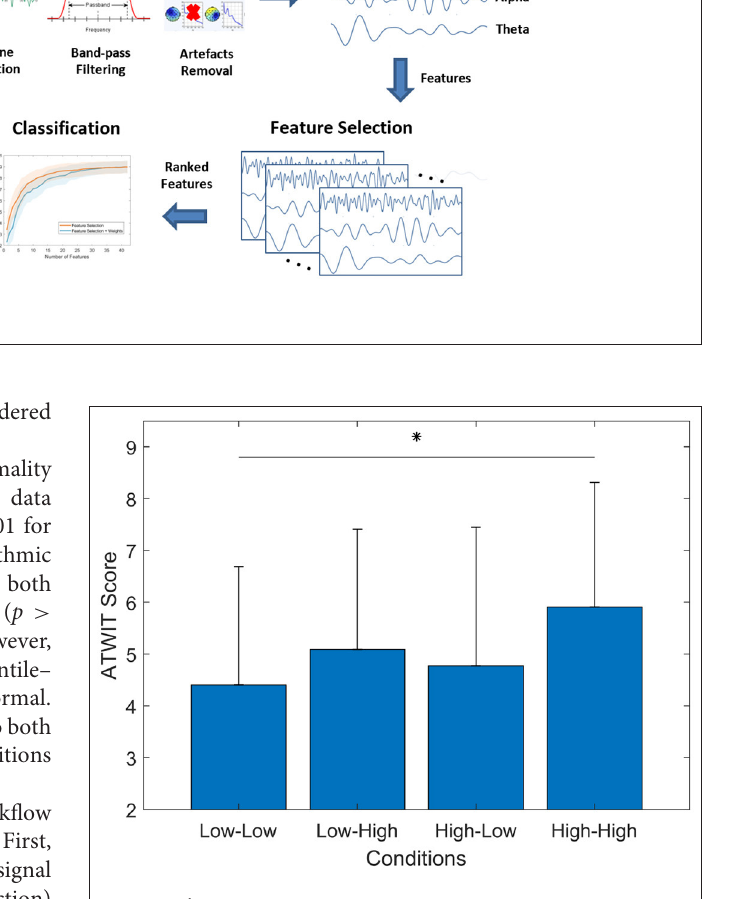
FIGURE 4 | The bar graph represents the mean and standard deviation of ATWIT scores. The Wilcoxon test showed a significant increase of workload ( p = 0.002). ∗ p <